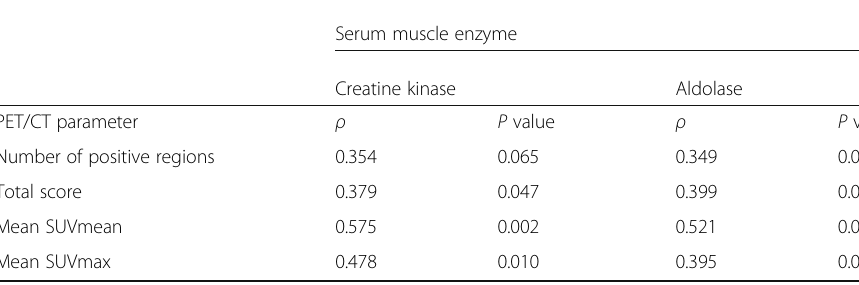
Table 3 Spearman ’ s correlation coefficient of 18 F-FDG PET/CT findings with serum muscle enzymes in patients with PM/DM Serum muscle enzyme Creatine kinase Aldolase PET/CT parameter